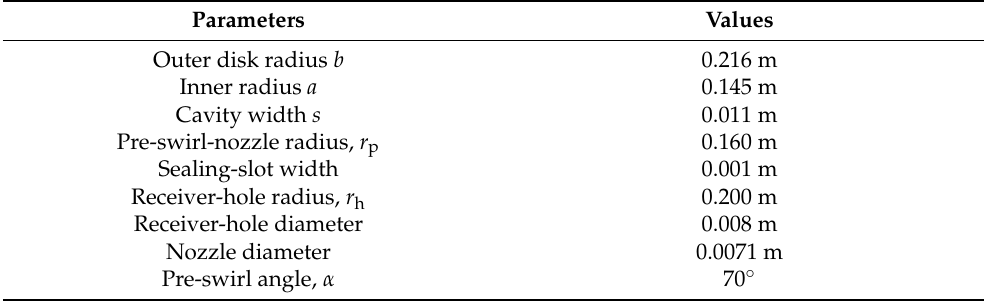
Table 1. Experimental geometry and operating conditions.